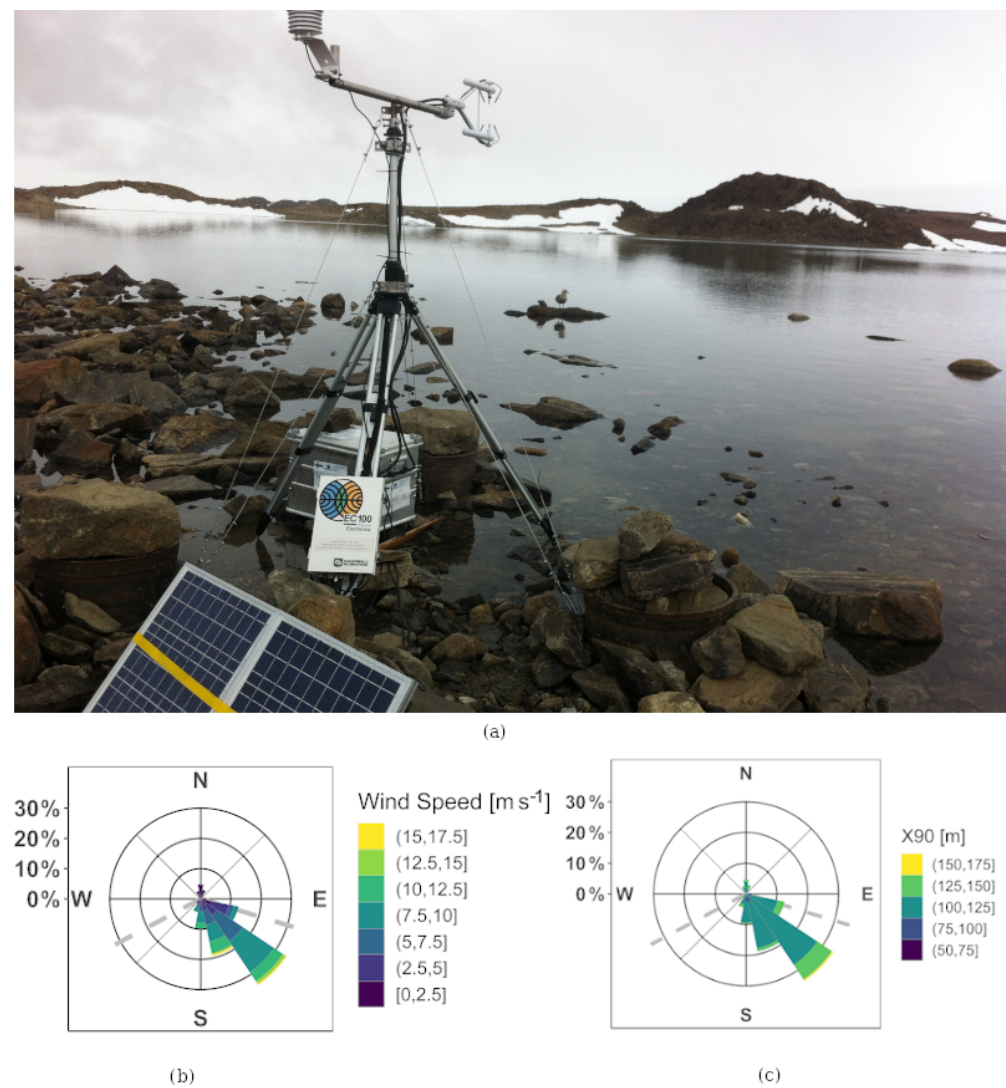
Figure 3. The experiment on the coast of Lake Zub/Priyadarshini: (a) IRGASON installed on the lake shore (6 January 2018); (b) wind speed and direction measured at the IRGASON site – dashed line indicates the footprint wind sector; (c) the footprint length estimate